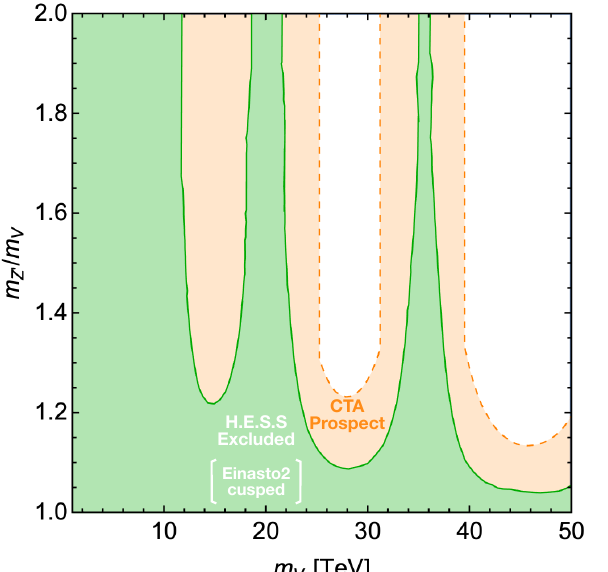
Figure 4 . The current bound from the H.E.S.S. observation and the prospect in the CTA ex- periment. The green region is excluded by the H.E.S.S. collaboration for the Einasto2 profile [34] shown in the lower panel of figure 3. The orange region with the dashed boundary is the prospect sensitivity in the CTA experiment for the cored Einasto profile with r = 5 kpc, which is the most c conservative one [40]. If we take r . 2 kpc, the prospect sensitivity will cover the whole region of c this